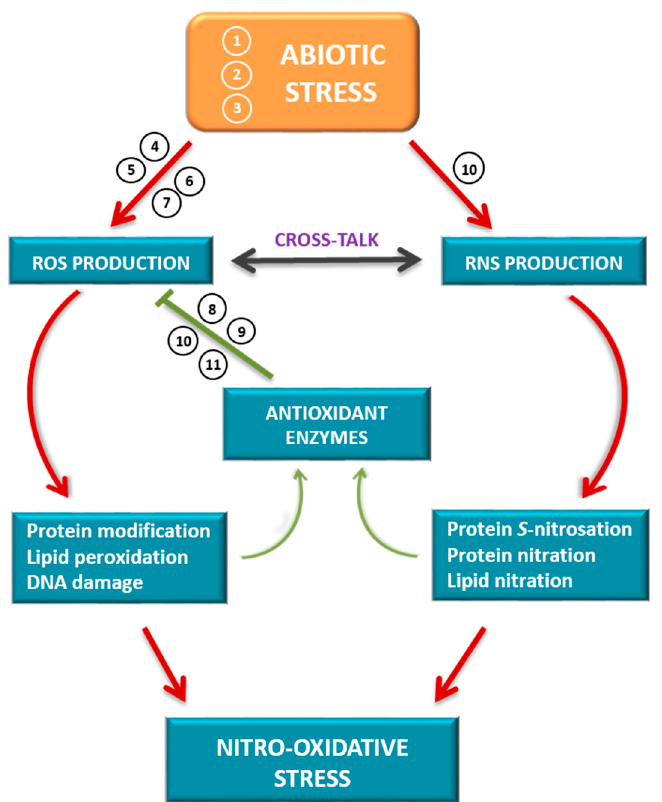
Figure 1. Schematic model of cross-talk between reactive oxygen species (ROS) and reactive nitrogen species (RNS) in plant responses to abiotic stress. Different abiotic stress situations can generate an uncontrolled production of ROS and RNS that oxidatively modify different biomolecules (proteins, lipids and nucleic acids). These modifications can lead to a gain of function of the antioxidant systems to control the production of ROS or generate a situation of cellular damage supported by a process of nitro-oxidative stress. The numbers indicate the relationship of each article in the Special Issue to the subject matter covered. (1) El-Esawi et al., 2020 [1]. (2) Begara-Morales et al., 2019 [2]. (3) García-Martí